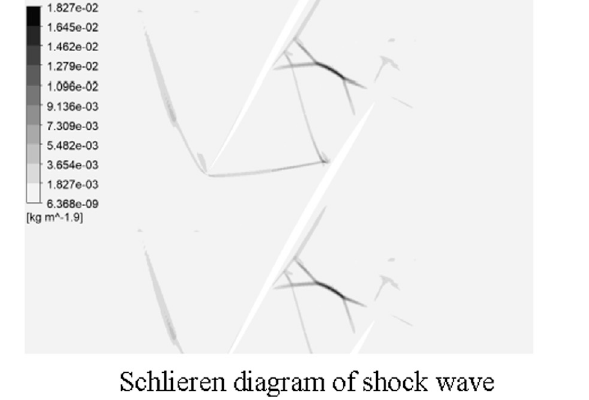
FIGURE 4 | Flow fi eld contours of the cascade. (A) Mach number contoursofthesupersoniccascade. (B) Schlierendiagramoftheshockwave.